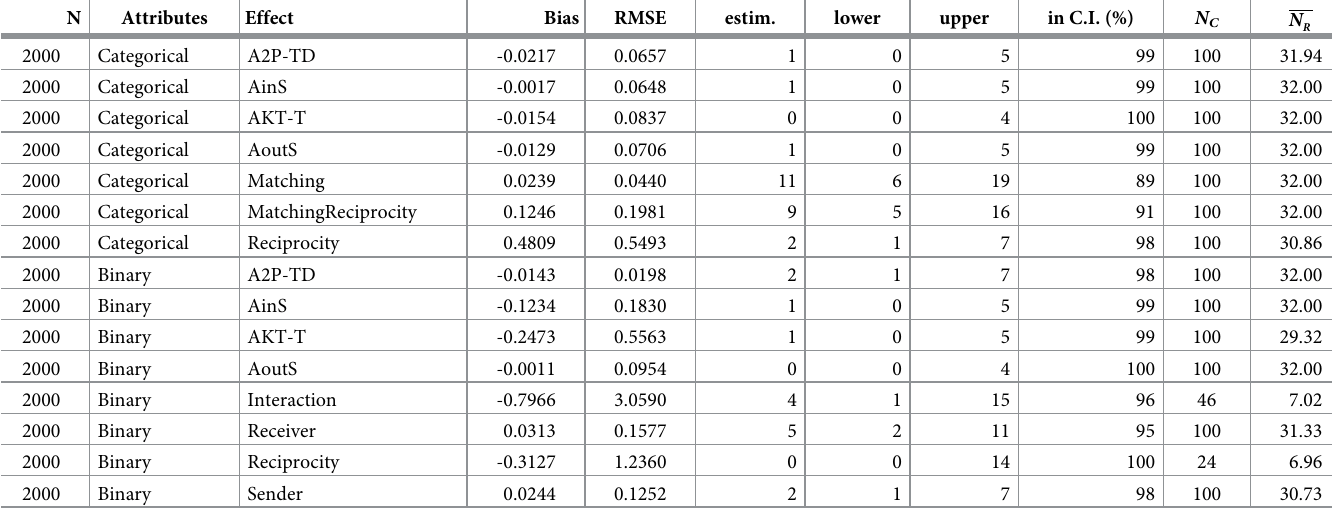
Table 3. Results from estimation of full network using EstimNetDirected estimating Type I error